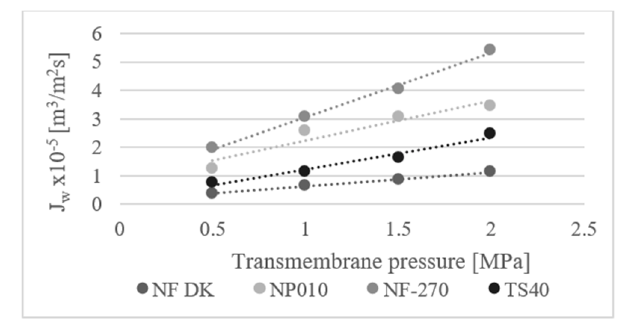
Figure 1. Dependence of the volumetric water on the transmembrane pressure for nanofiltration membranes.